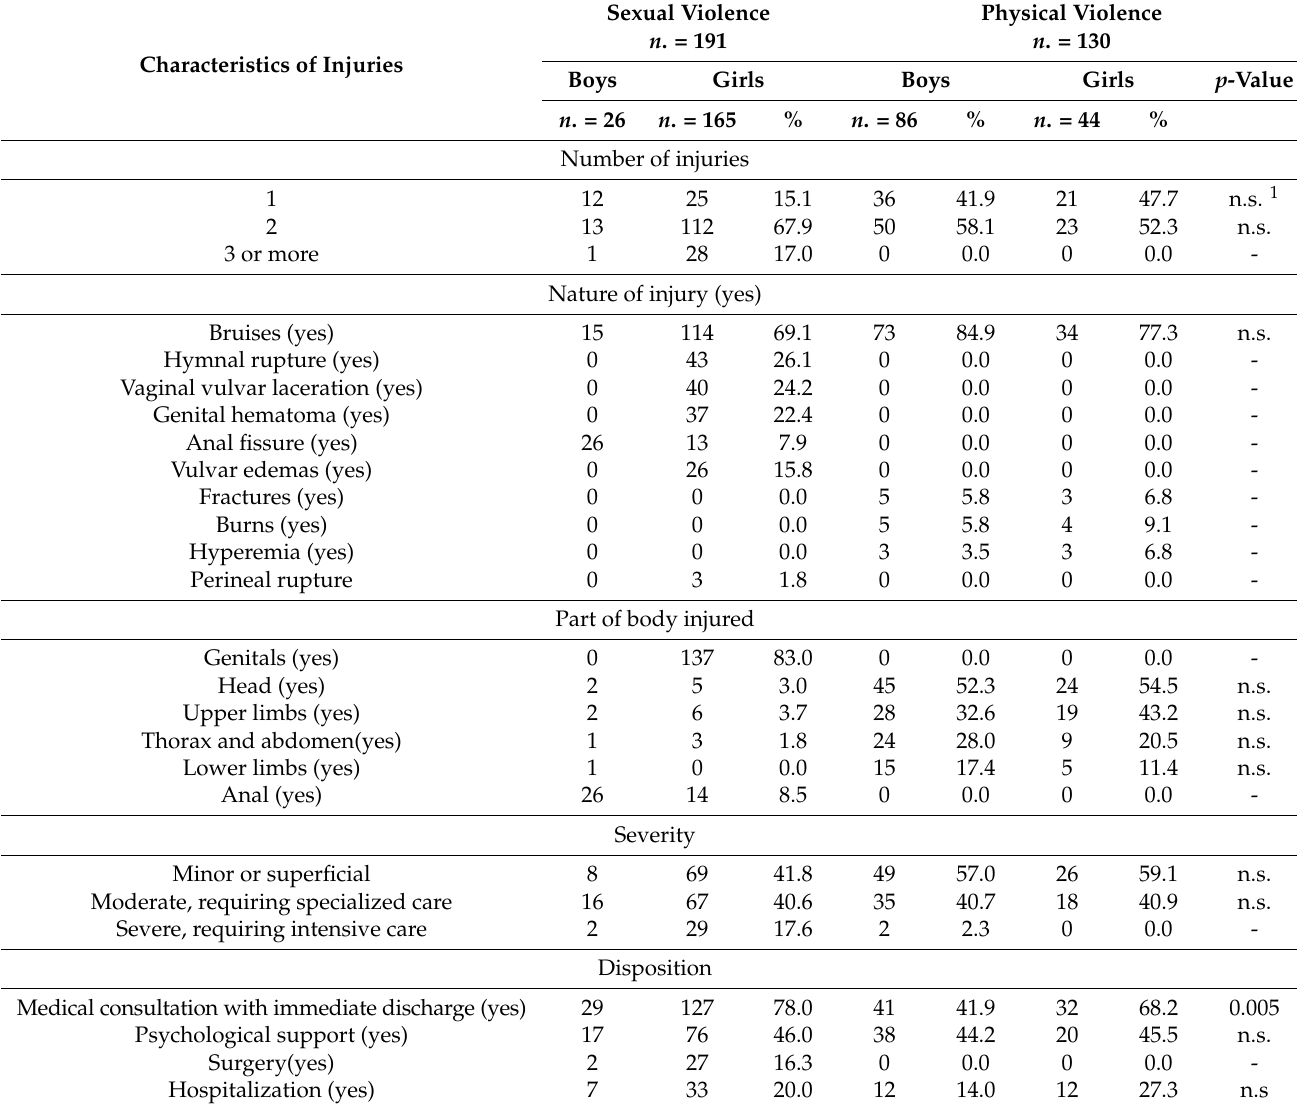
Table 3. Sex-related difference in the characteristics of violence-related injuries among pediatric patients seen at pediatric emergency and forensic medicine at MCH, from 1 January to 31 December